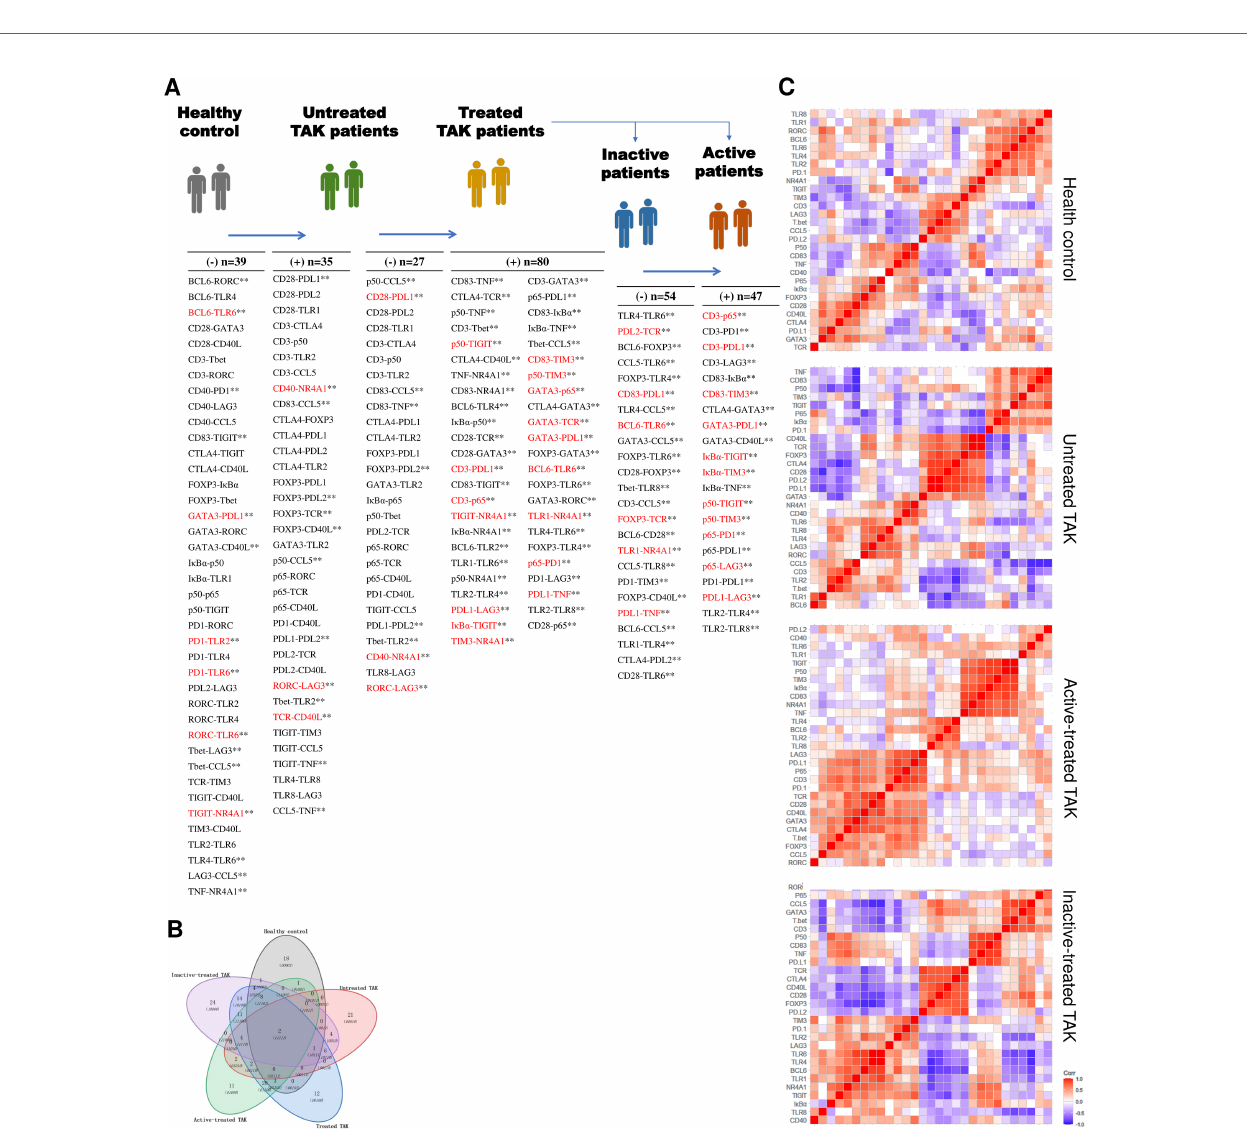
FIGURE 9 | Characteristic gene co-expressions across different conditions. (A) A list of characteristic co-expressed gene pairs comparing the two adjacent groups, which re fl ected changes in the activated signaling pathways. The newly discovered co-expression relationships which had never been reported in STRING or Coexpedia database were indicated red. Pearson correlation analysis. Untreated TAK Vs. healthy controls, p < 0.05. Treated TAK Vs. Untreated TAK, p < 0.01. Active-treated TAK Vs. inactive-treated TAK, p < 0.01. **p < 0.01. (B) Overlapping co-expressions among the fi ve conditions. (C) Hierarchical clustering heatmaps of the target genes with the distance calculated using Pearson correlation. TAK, Takayasu ’ s